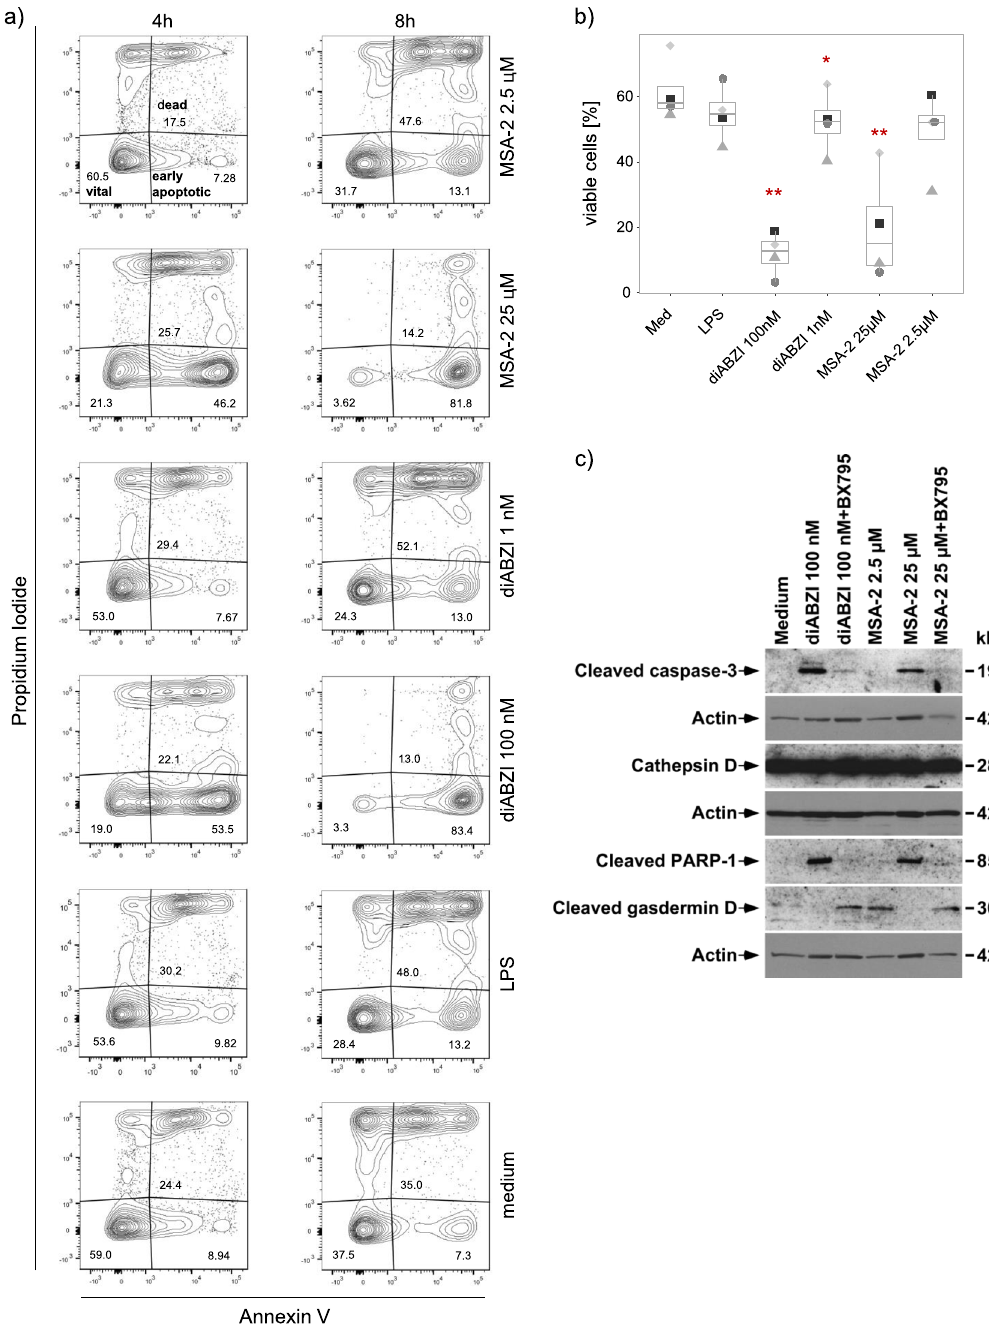
Figure 5. Cell death induction in monocytes by STING ligands. Purified monocytes were cultured in medium or were stimulated for 4 and 7 or 8 h with 100 ng/mL LPS or the indicated concentrations of STING ligands. Cell death was analyzed by flow cytometry following PI/annexin V staining and by Western blot analysis. ( a ) Contour plot of a representative experiment, left panel: 4 h, right panel: 8 h. ( b ) Summary of four experiments, displayed as proportion of viable (PI − /annexin V − ) cells. Statistical significance was calculated by paired Student’s test. Red asterisks indicate the level of significance between stimulated and unstimulated (medium) samples. *p < 0.05, **p < 0.01. ( c ) Western blot analysis of death-associated proteins in monocytes after stimulation for 7 h with the indicated concentrations of STING